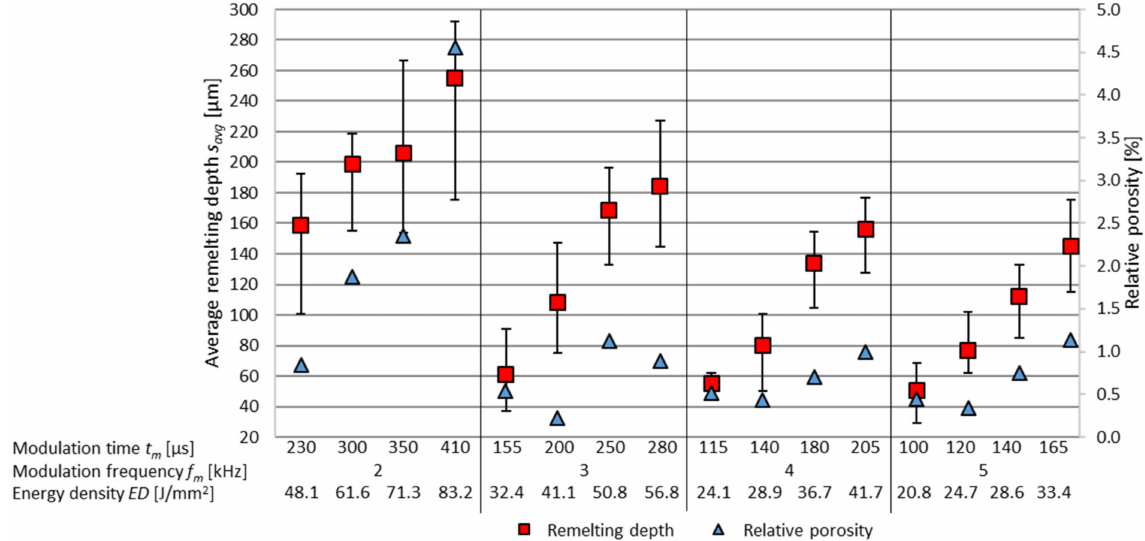
Figure 14. Average remelting depth s avg and relative porosity depending on the modulation frequency f m and modulation time t m